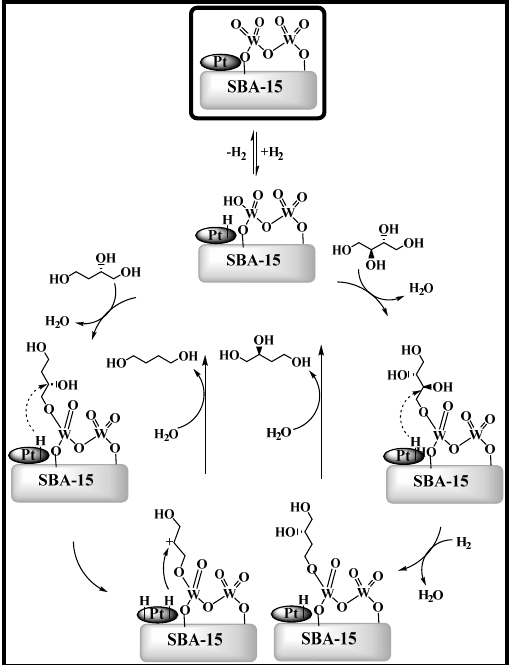
Figure 7. Proposed reaction mechanism for the hydrogenolysis of erythritol to 1,4-BDO over Pt/W/SBA-15 catalysts.